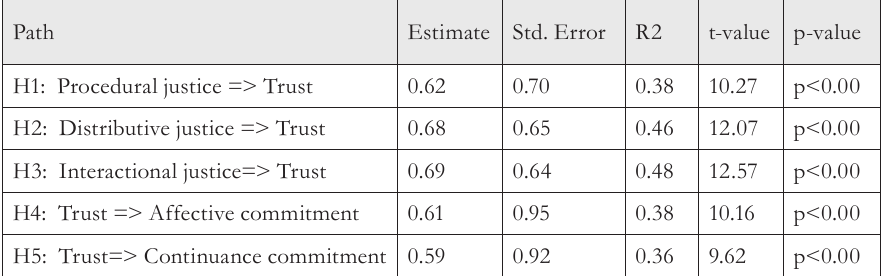
Tab.6 - Standardized parameter estimates of hypothesized paths. Source: Authors